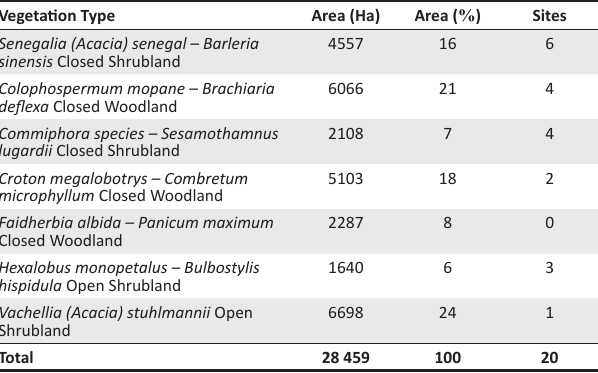
TABLE 2: The seven vegetation types found in Mapungubwe, total area and percentage of area covered by each type and number of transects sampled in each vegetation